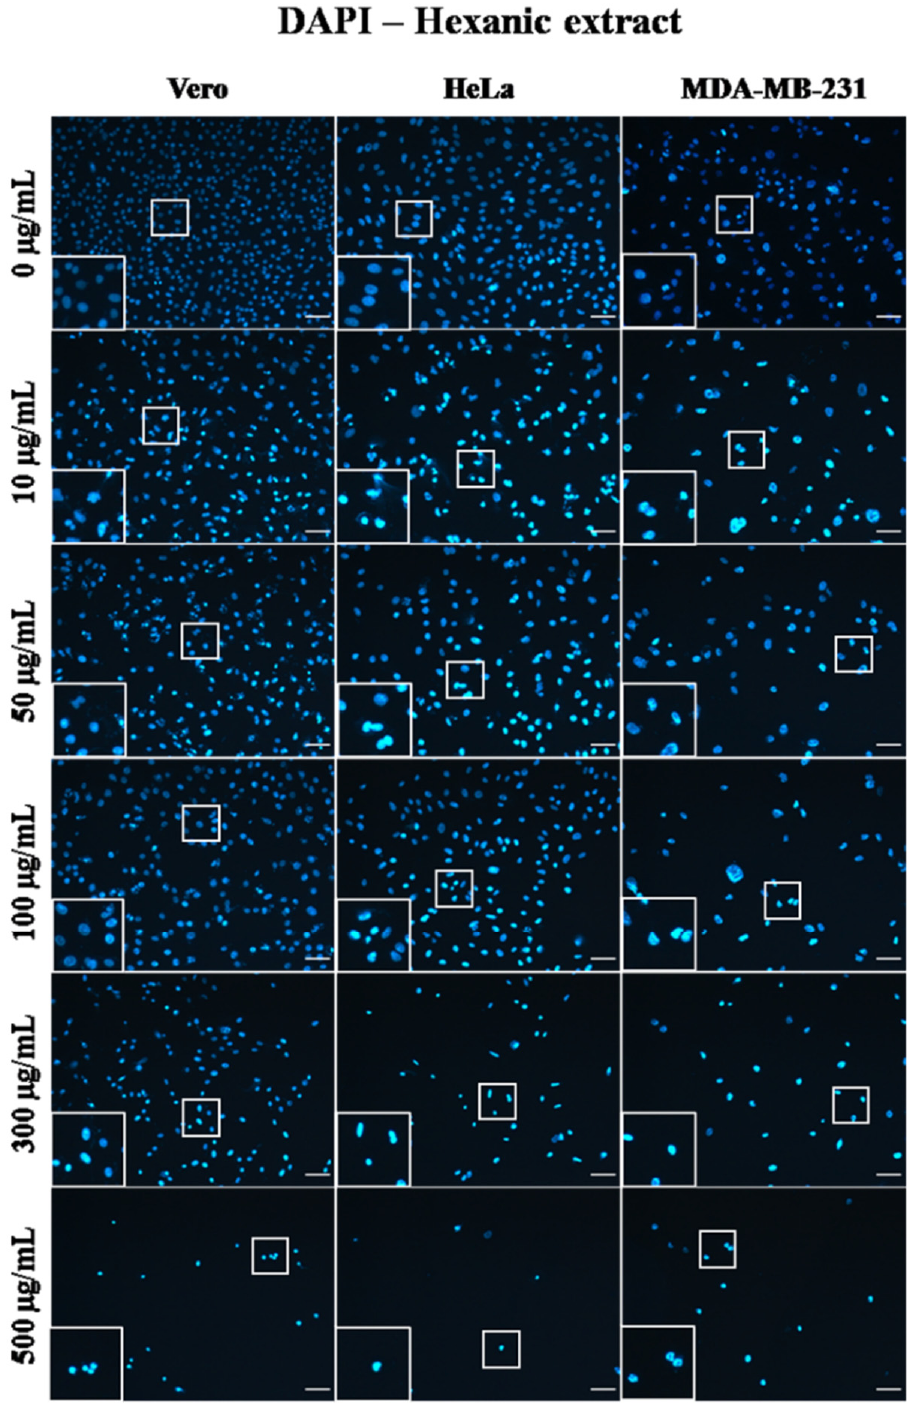
Figure 4. Micrographs of Vero, HeLa, and MDA-MB-231 cells exposed for 24 h to 0, 10, 50, 100, 300, and 500 µg/mL of A. monostachya HE. Nuclei labeling with DAPI. The nuclei of tumor cells showed obvious morphological alterations, such as pyknosis, rounding, and intense fluorescence as well as a marked decrease in confluence after exposure to the lowest concentration (10 µg/mL) of the extract. The HeLa cells showed more evident changes compared to Vero cells followed by the MDA-MB-231 cells, which showed these changes at higher concentrations. These alterations were also time- and concentration-dependent. Scale bar = 50 µ